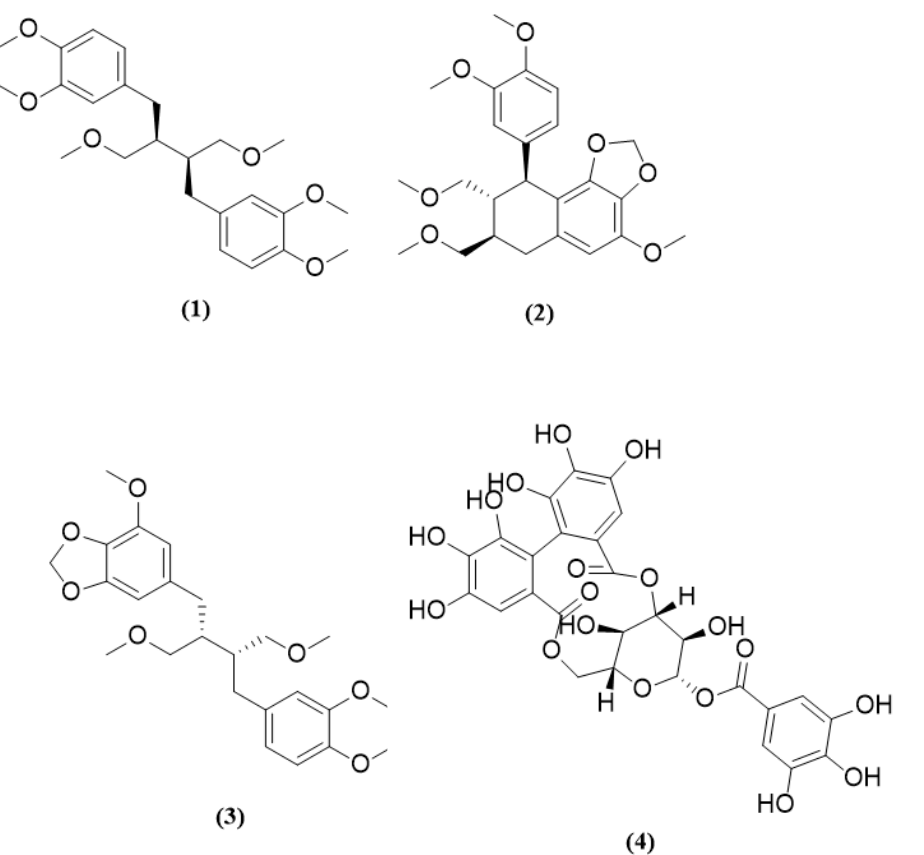
Figure 1. P. Amarus compounds: phyllanthin ( 1 ), hypophyllanthin ( 2 ), niranthin ( 3 ), corilagin ( 4 ). Table 1. Linearity, limit of detection (LOD) and limit of quantification (LOQ) of compounds. Chemical Marker